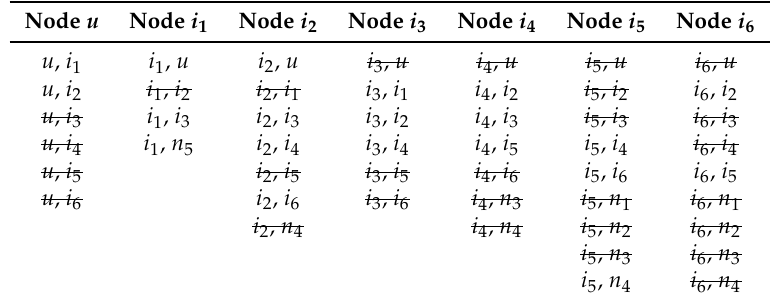
Table 2. The local planar graph edge lists of node u and its neighbors in Figure